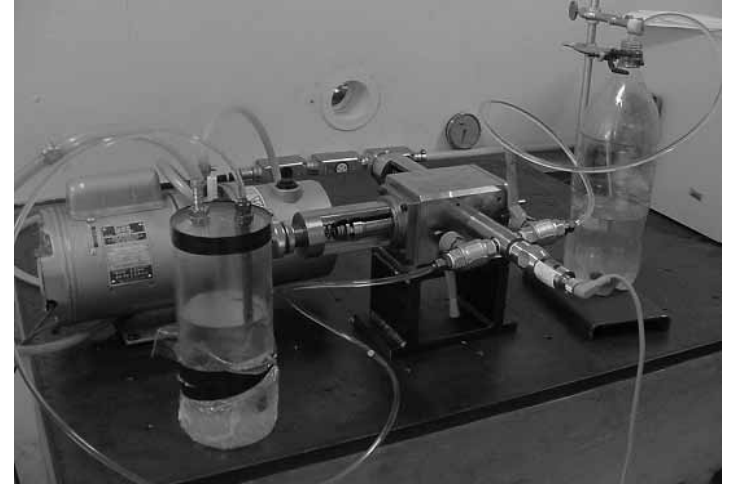
Fig. 7. Assembly of the active